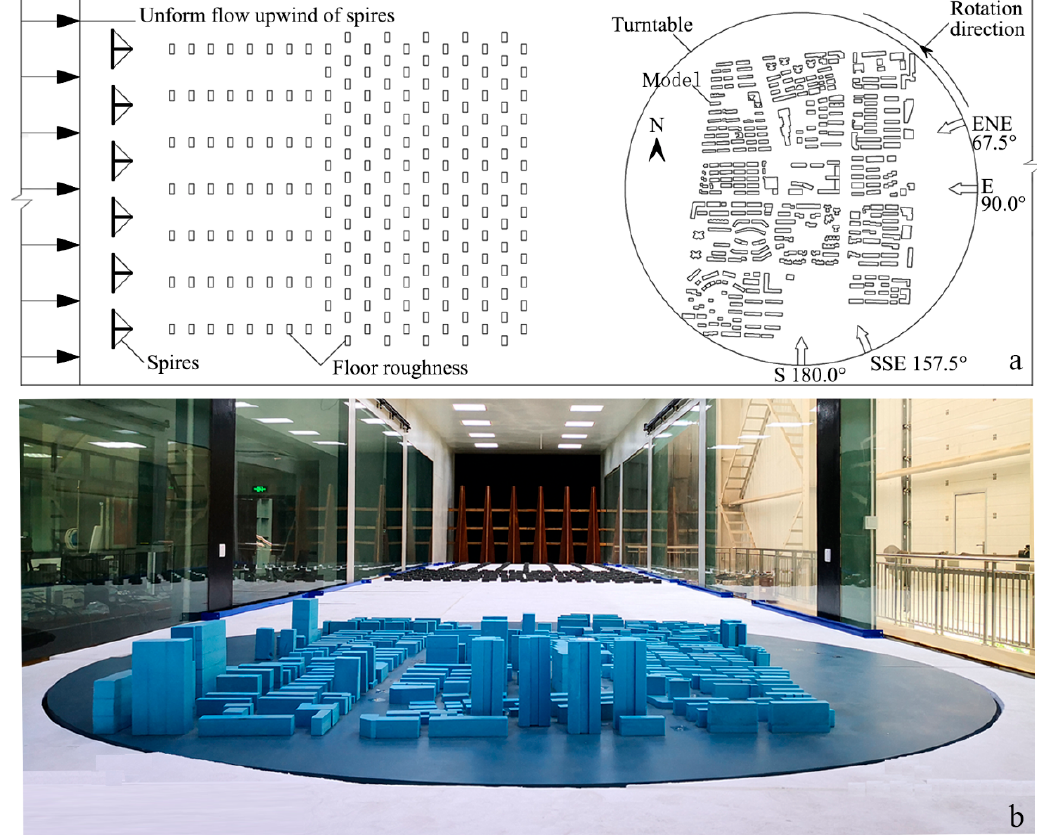
Figure 4. ( a ) Wind tunnel plane diagram. ( b ) Photo of the model in the wind tunnel. Table 1. Wind tunnel experimental conditions.